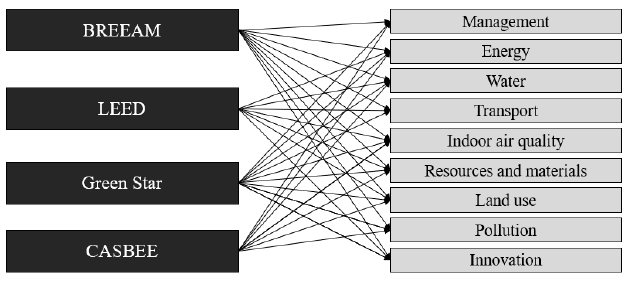
Fig. 6. The certificate systems and criteria examined within